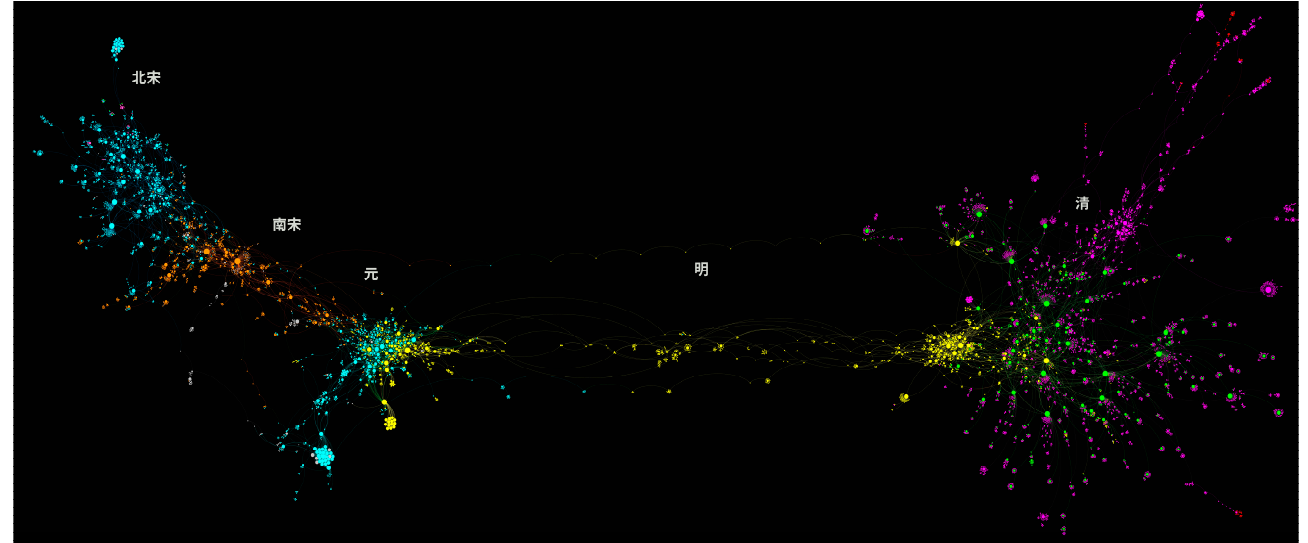
Figure 1. Overview of the part of the network ranging from the Northern Song to the Qing. (Node colors (from left to right): Blue : died in the Northern Song; Orange : died in the Southern Song; Cyan : died in the Yuan; Yellow : died in the Ming; Green : born in the Ming but died in the Qing; Purple : born and died in the Qing).